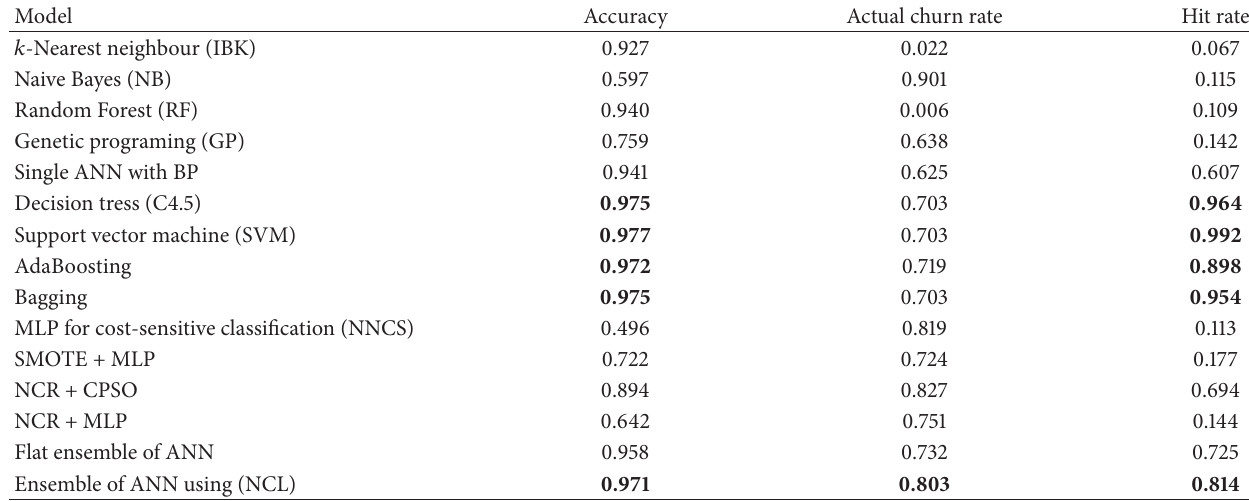
Table 6: Evaluation results (results of best five models are shown in